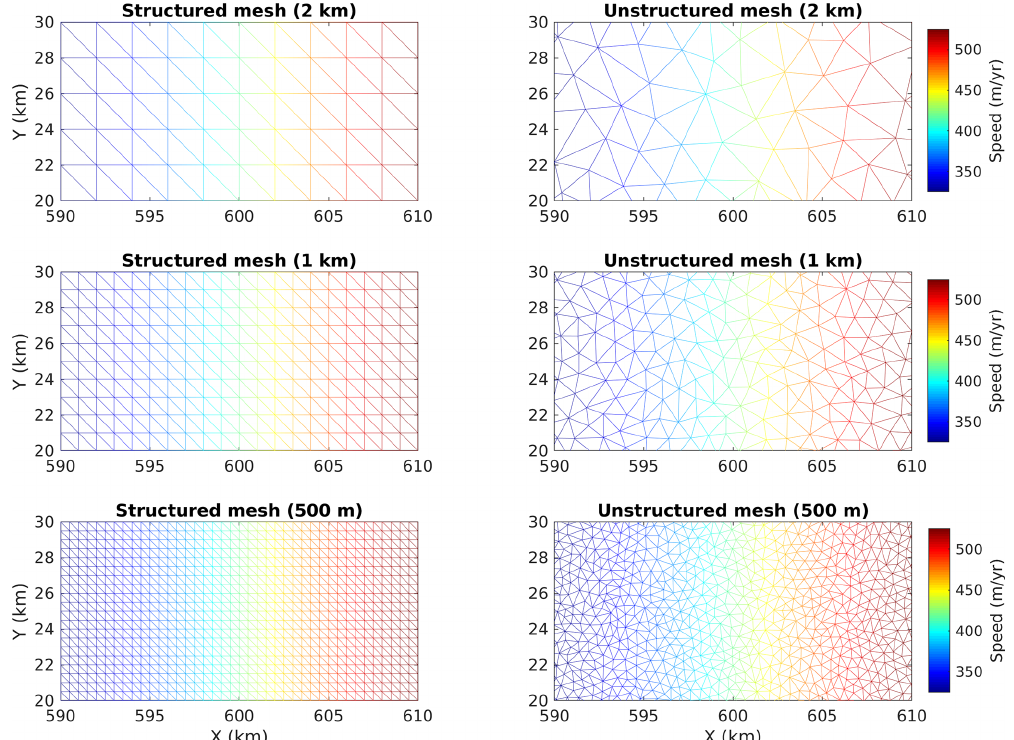
Figure B1. Examples of meshes employed in this work. Left panels are structured conforming meshes, and right panels the unstructured meshes. Three mesh resolutions are shown: 2, 1, and 0 . 5km. The color maps are the ice speeds obtained in the diagnostic analysis (Sect. 5.1) considering the grounding line at x = 600km. Note that the structured meshes are conforming to the grounding line; i.e., they are generated such that the elements’ edges match the grounding line position (in this case, x gl = 600km). Sub-element parameterizations SEP1 + NSED are employed in the unstructured meshes to computed the ice speeds presented